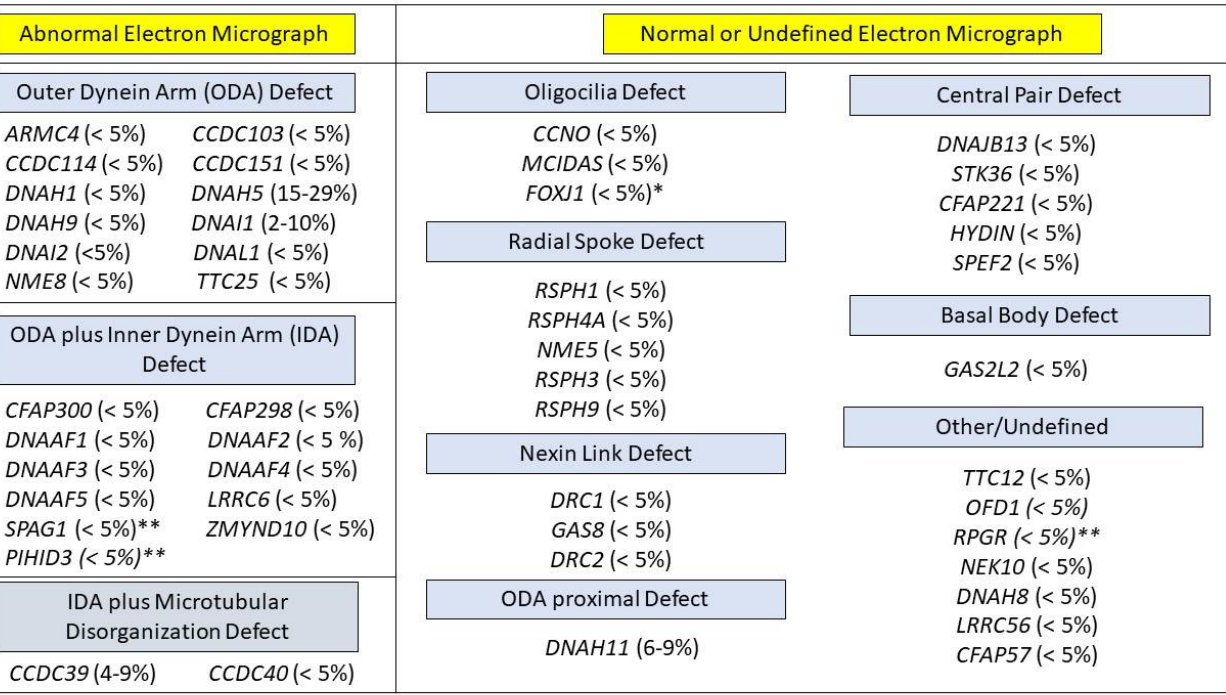
Figure 2. PCD genotypes, grouped by expected ciliary ultrastructure on electron micrograph (EM). Genotypes with an x-linked mode of inheritance are labeled with **. Genotypes in with an autosomal dominant mode of inheritance are labled with *. All other genotypes have an autosomal recessive mode of inheritance. Approximate prevalence of each genotype appears in paretheses.